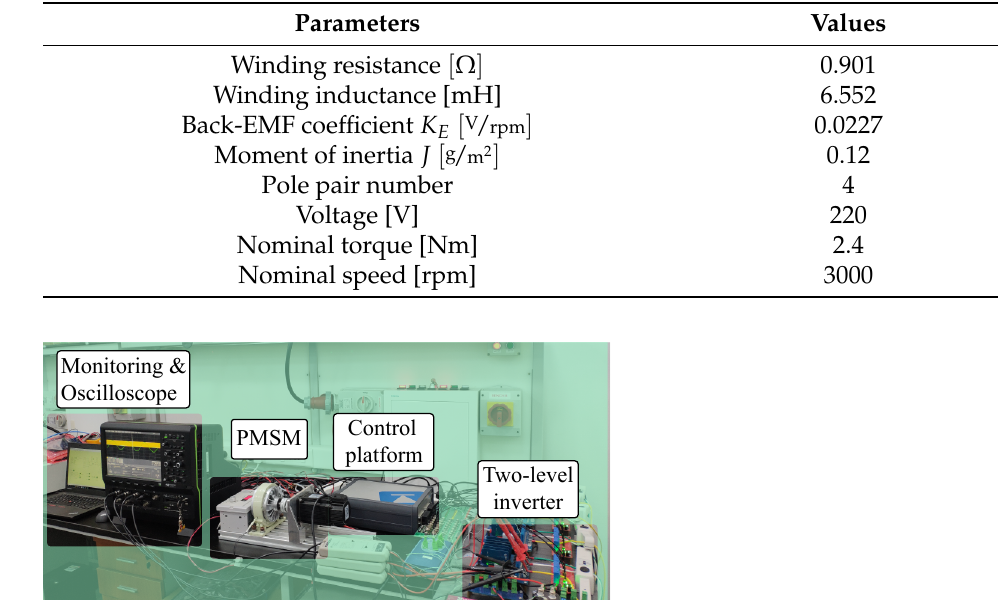
Table 1. Multi-phase PMSM parameters.